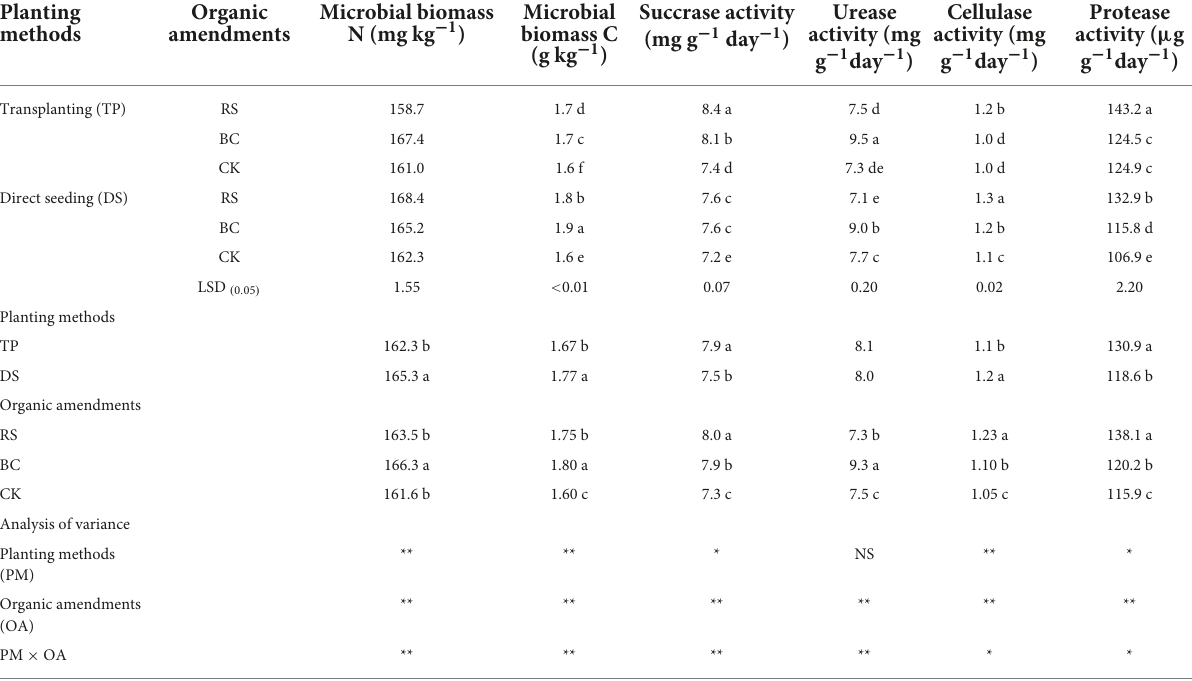
TABLE 2 Soil enzyme activity and microbial biomass under different treatments of planting methods and organic amendments. Planting methods